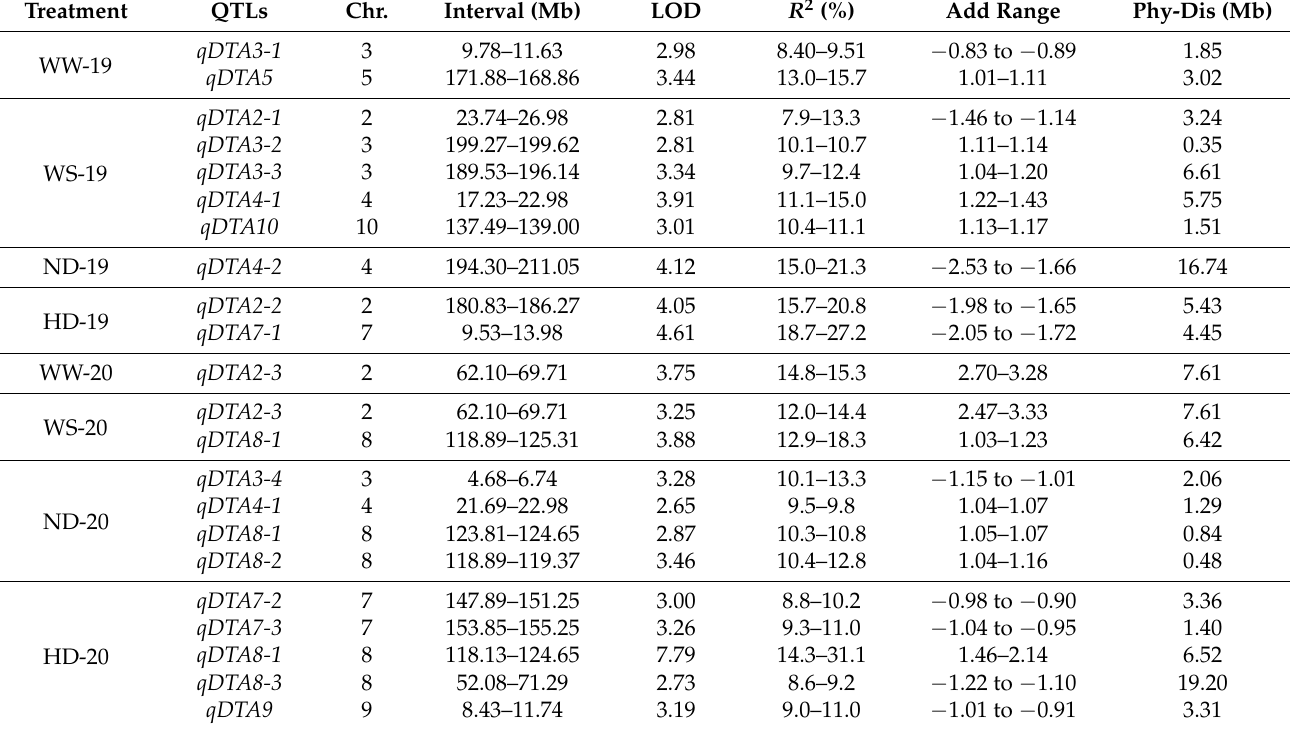
Table 2. QTLs identified for DTA under two water regimes and planting densities during 2019 and